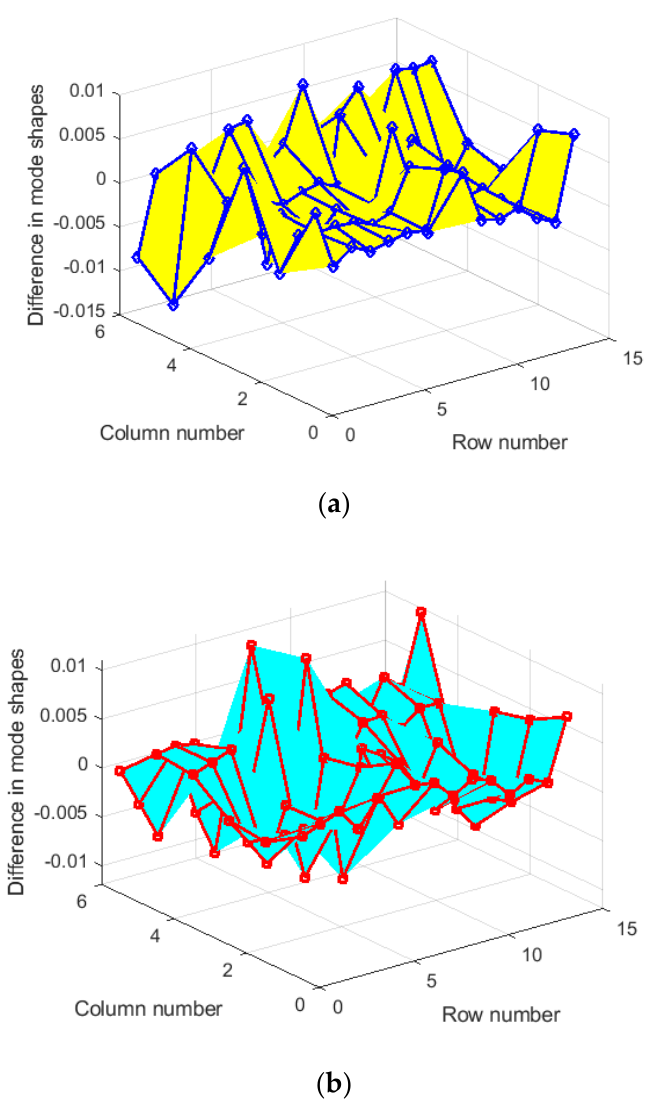
Figure 4. Difference between actual and estimated slave mode shape matrix. ( a ) EI method; ( b ) G‑EI method. The values in the z axis indicate its corresponding row and column in the mode shape matrix.